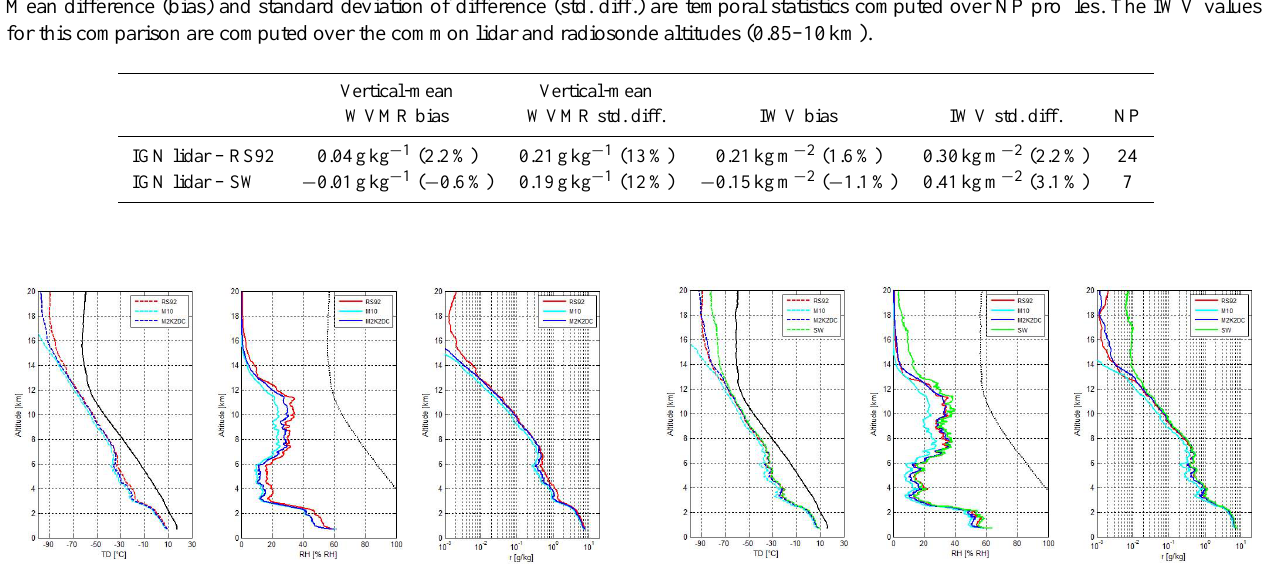
Fig. 8. Comparison of mean TD, RH and WVMR profiles from RS92, M10 and M2K2DC (22 flights). The black line in the TD plot shows the mean T profile from RS92 and the black dotted line in the RH plot shows the saturation RH over ice from RS92 mea- surements.